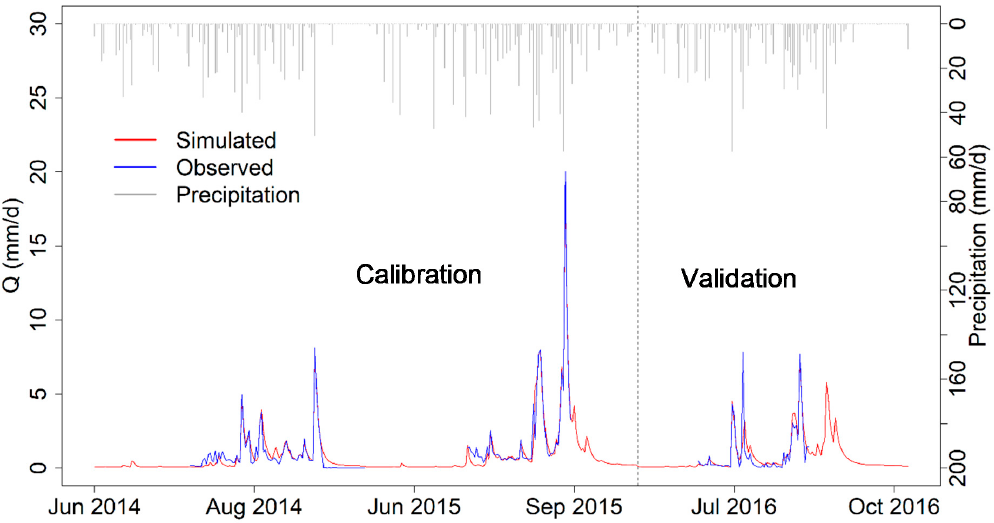
Figure 12 . Comparison of the simulated and observed hydrographs at the Mebar catchment during the calibration period of 2014–2015 and the validation year 2016. The vertical dash line separates the calibration period from the validation period.